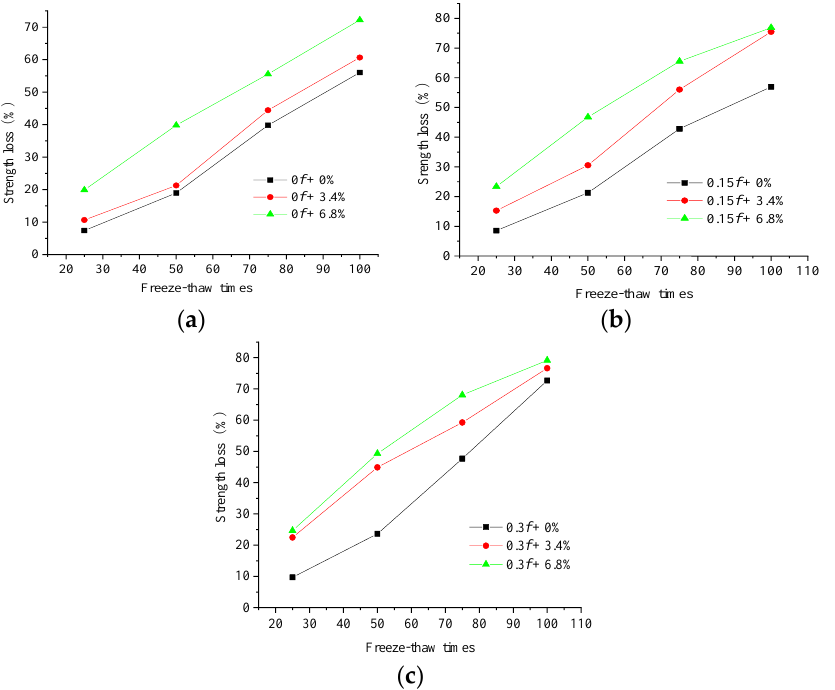
Figure 1. Compressive strength of concrete samples. ( a ) Without the initial load. ( b ) Initial load of 0.15 f . ( c ) Initial load of 0.3 f .